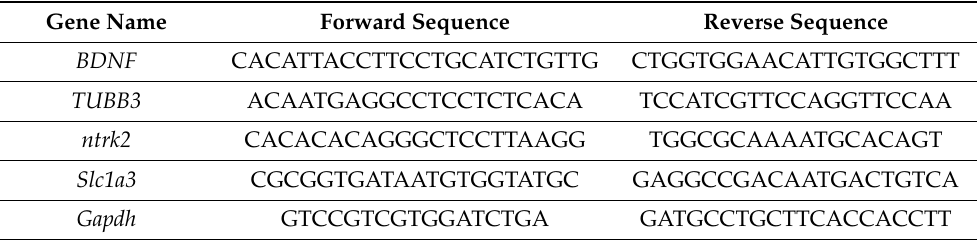
Table 3. Table reporting the primer sequences for the RT-PCR analysis. TUBB3 is the β 3-Tubulin gene, ntrk2 is the TrkB gene, and Slc1a3 is the GLAST